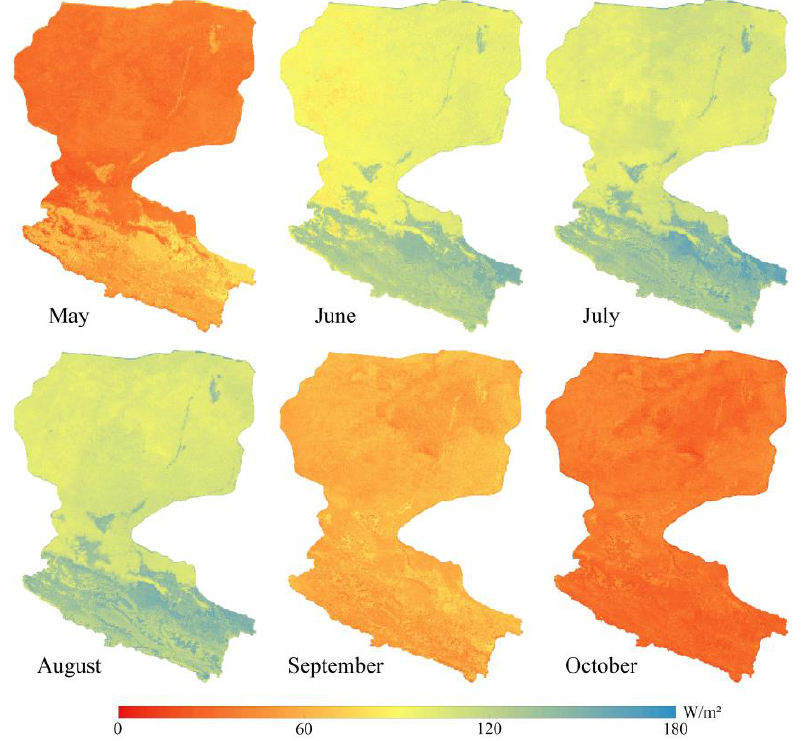
Figure 7. Spatial and temporal distribution of latent heat flux in HRB during the growing season (May to October) in 2018. (May to October) in